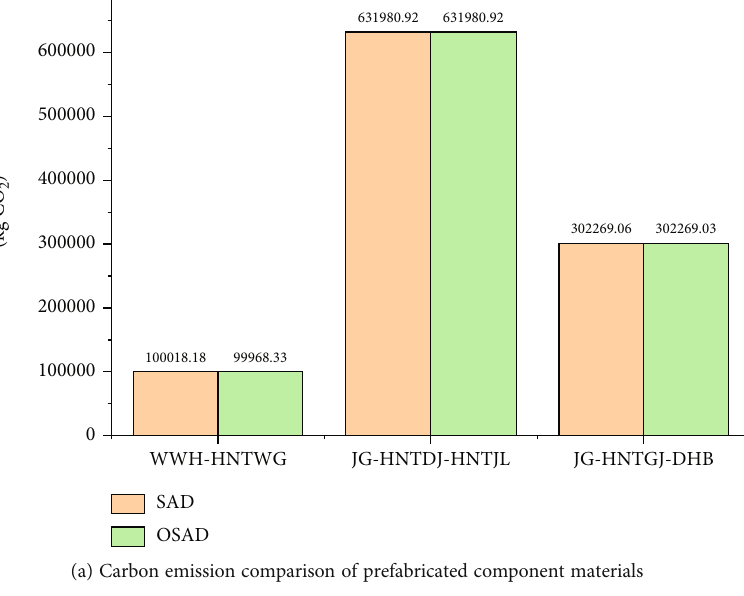
(a) Carbon emission comparison of prefabricated component materials